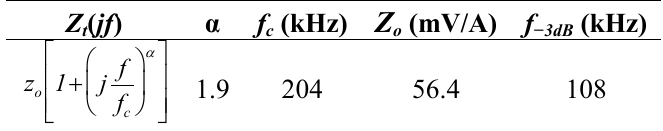
Table 4. TMR sensor with internal magnetization ac large-signal fractional modeling parameters.